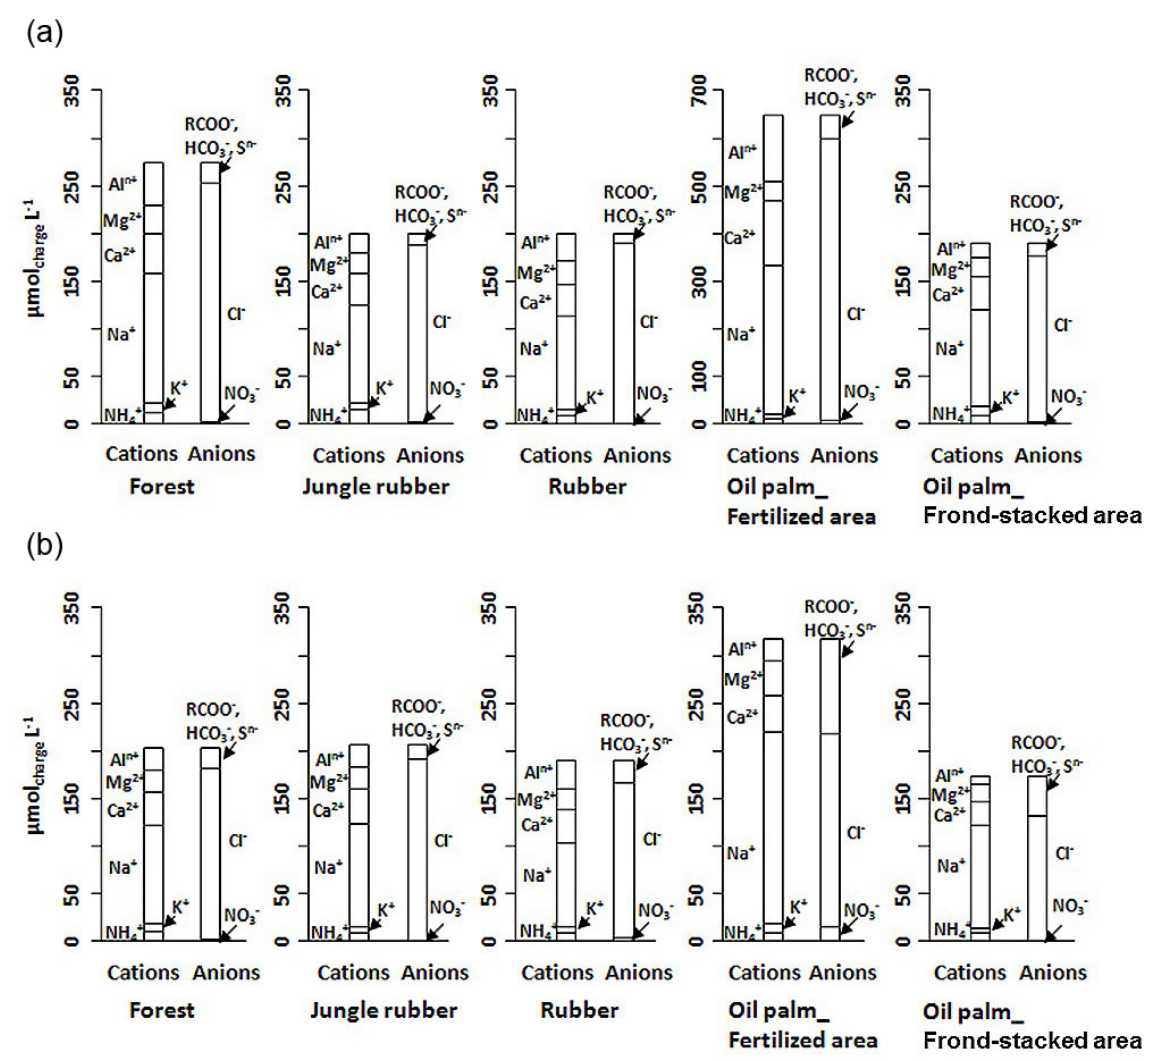
Figure 1. Partial cation–anion charge balance of the major solutes (with concentrations >0.03mgL − 1 ) in soil water at a depth of 1.5m in different land uses within the loam (a) and clay (b) Acrisol soils in Jambi, Sumatra, Indonesia. The y axis scale of the oil palm fertilized area in the loam Acrisol soil is twice that of the other land